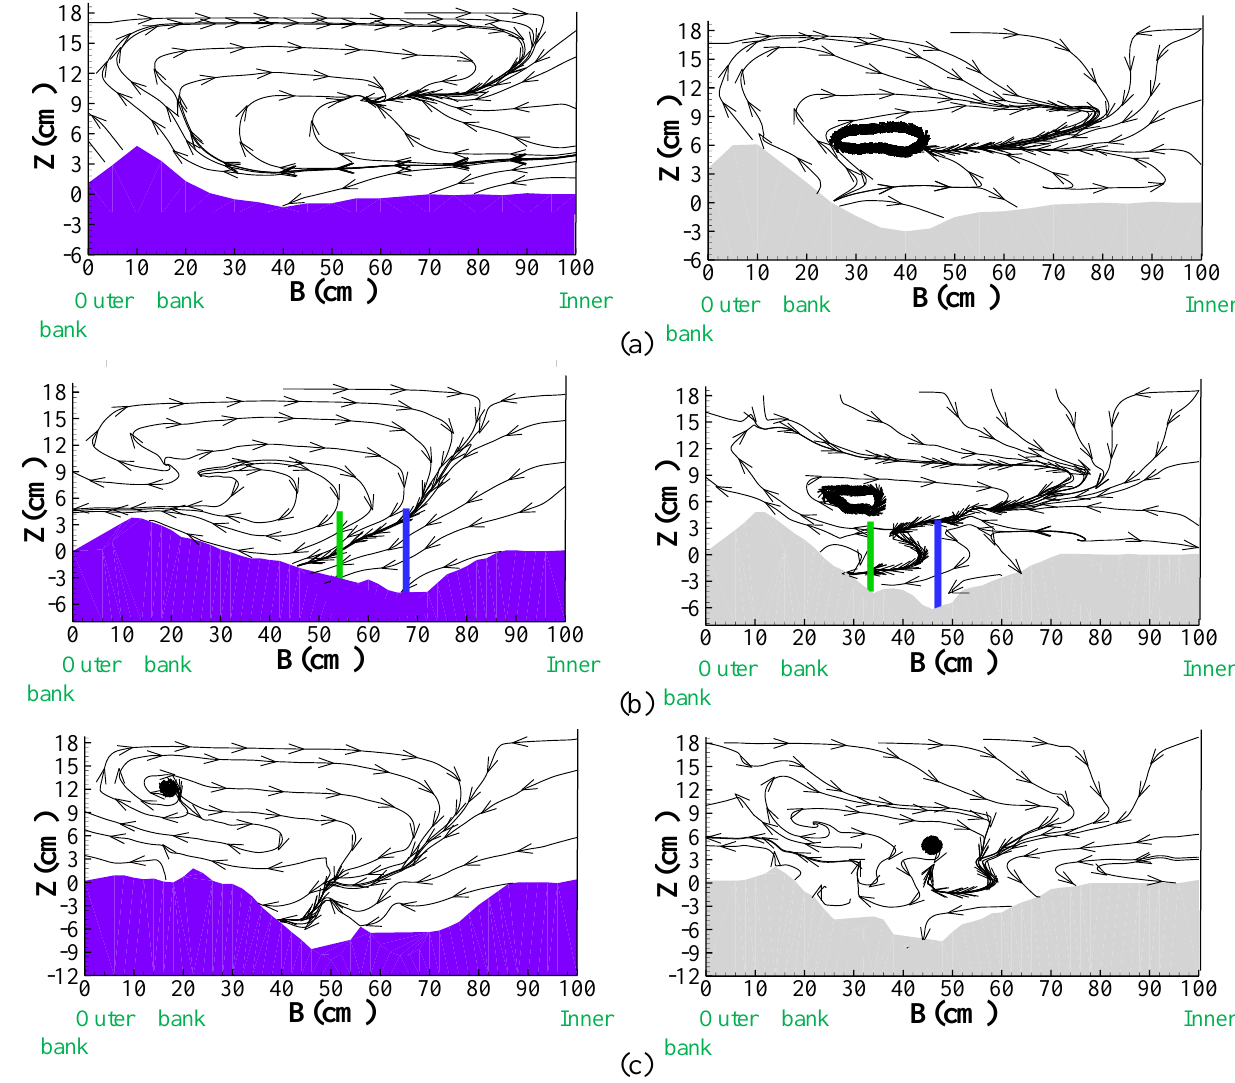
Figure 3. A view of the flow pattern in a) 75, b) 81.5, and c) 814.5 degree cross sections of the bend. (PFV experiment on the right, and PSV experiment on the